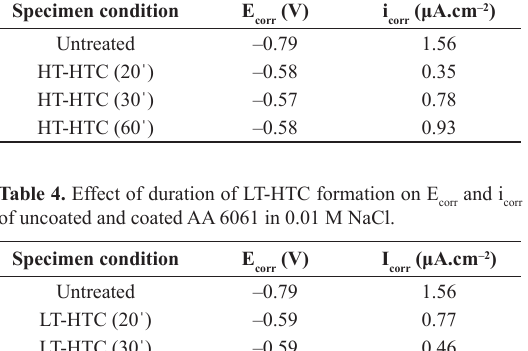
and i corr corr